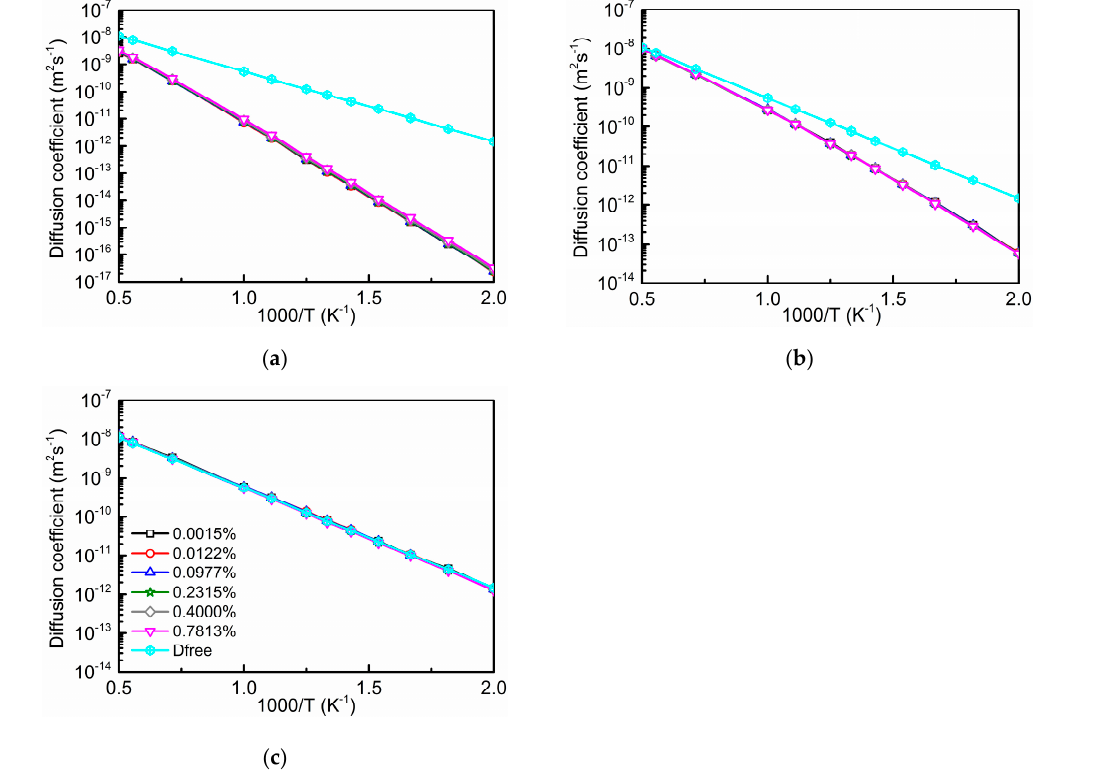
Figure 3. Di ff usion coe ffi cients of oxygen inside ( D inter ) and outside ( D free ) the interaction region with Figure 3. Diffusion coefficients of oxygen inside ( Ti ( a ), Cr ( b ), and Si ( c ), for di ff erent concentrations c S (in at.%) of these substitutional with Ti ( a ), Cr ( b ), and Si ( c ), for different concentrations